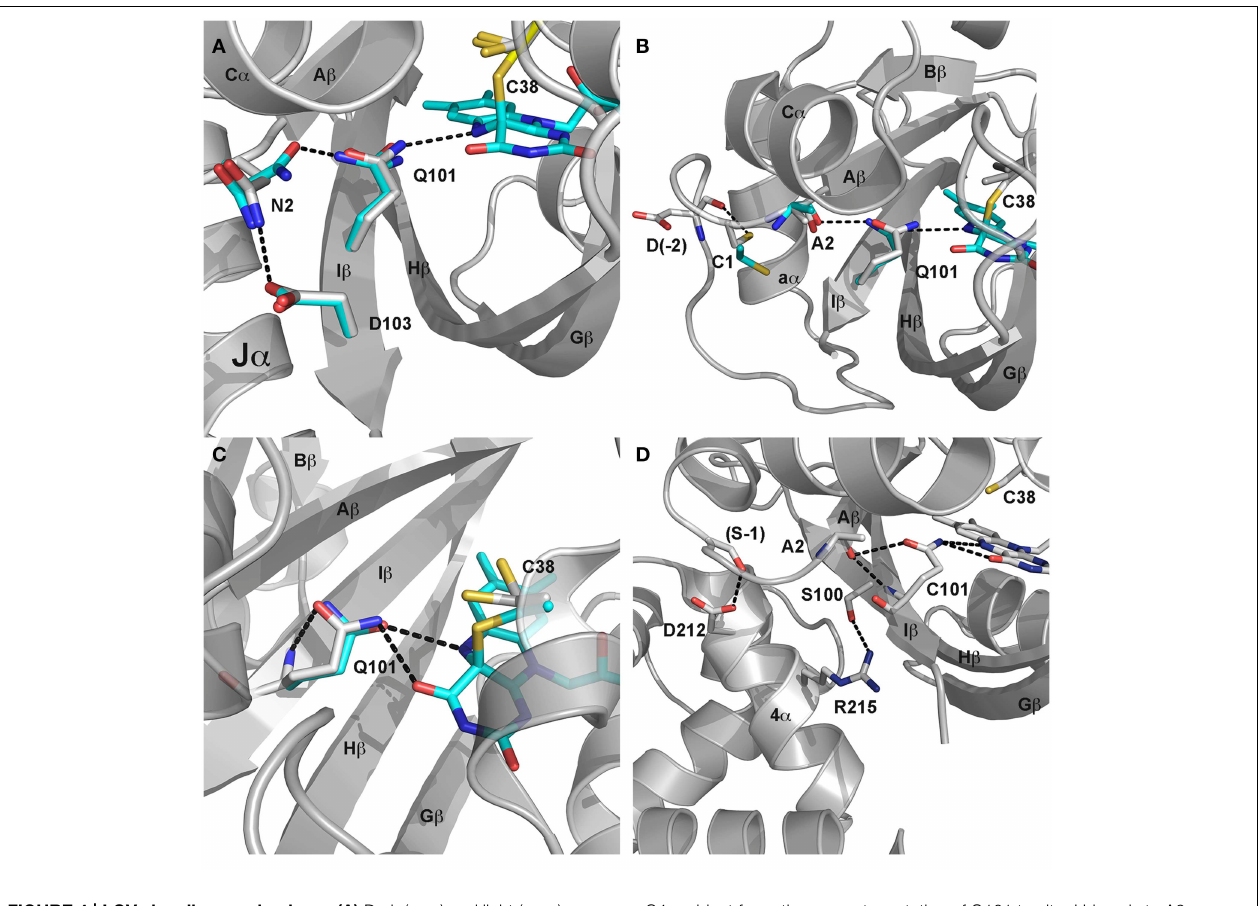
FIGURE 4 | LOV signaling mechanisms. (A) Dark (gray) and light (cyan) state structures of AsLOV2. Photoactivation leads to rotation of Q101 to alter H-bonding contacts to N2. N2 undergoes a light driven interchange involving contacts with D103 and Q101. The H-bond switch affects Ncap structure to disorder the J α helix. (B) Dark (gray) and light (cyan) state structures of VVD.